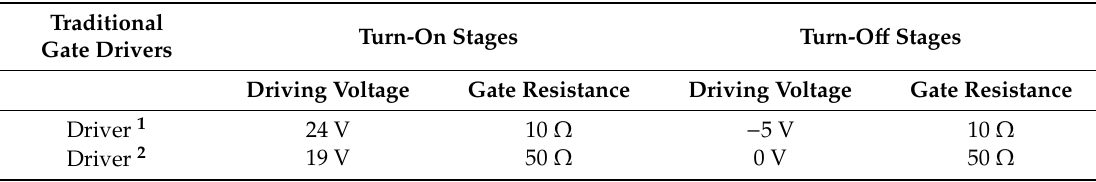
Table 3. Driving parameters of traditional gate drivers.